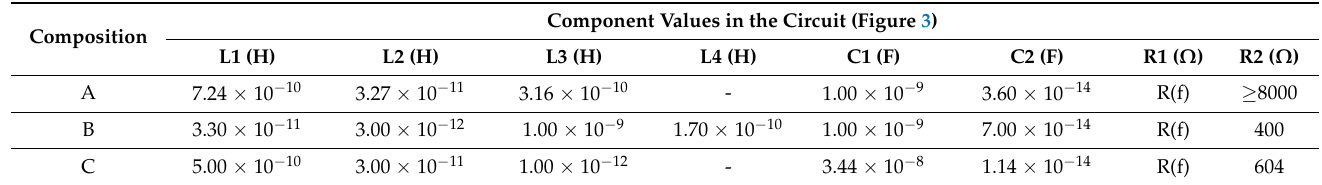
Table 2. Component values of the lumped-element circuit (Figure 3) for scaffold composites of Wangi rice starch and nHA at X-band.